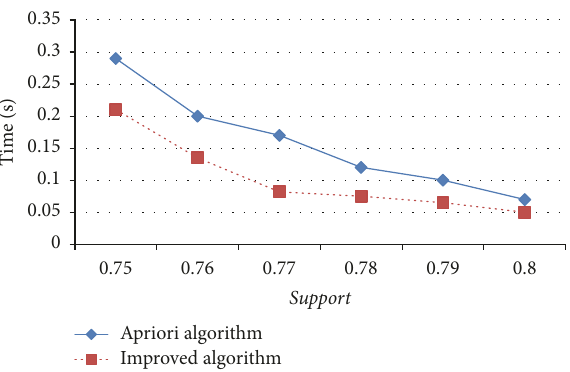
Figure 2: Runtime of the two algorithms on soybean